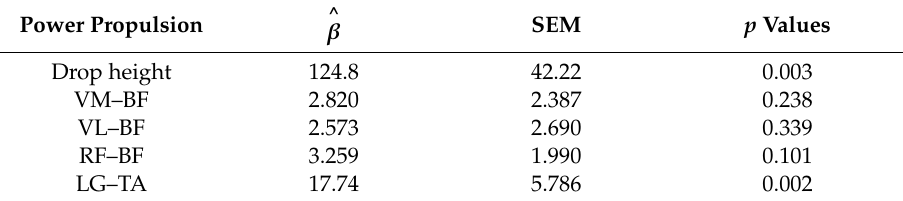
Table 2. Power propulsion linear mixed model coactivation